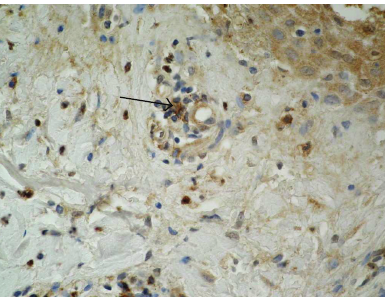
Figure 6: Skin lesions in BP, immunohistochemistry. Moderate ex- pression of L-selectin on leucocytes (original magnification x100).